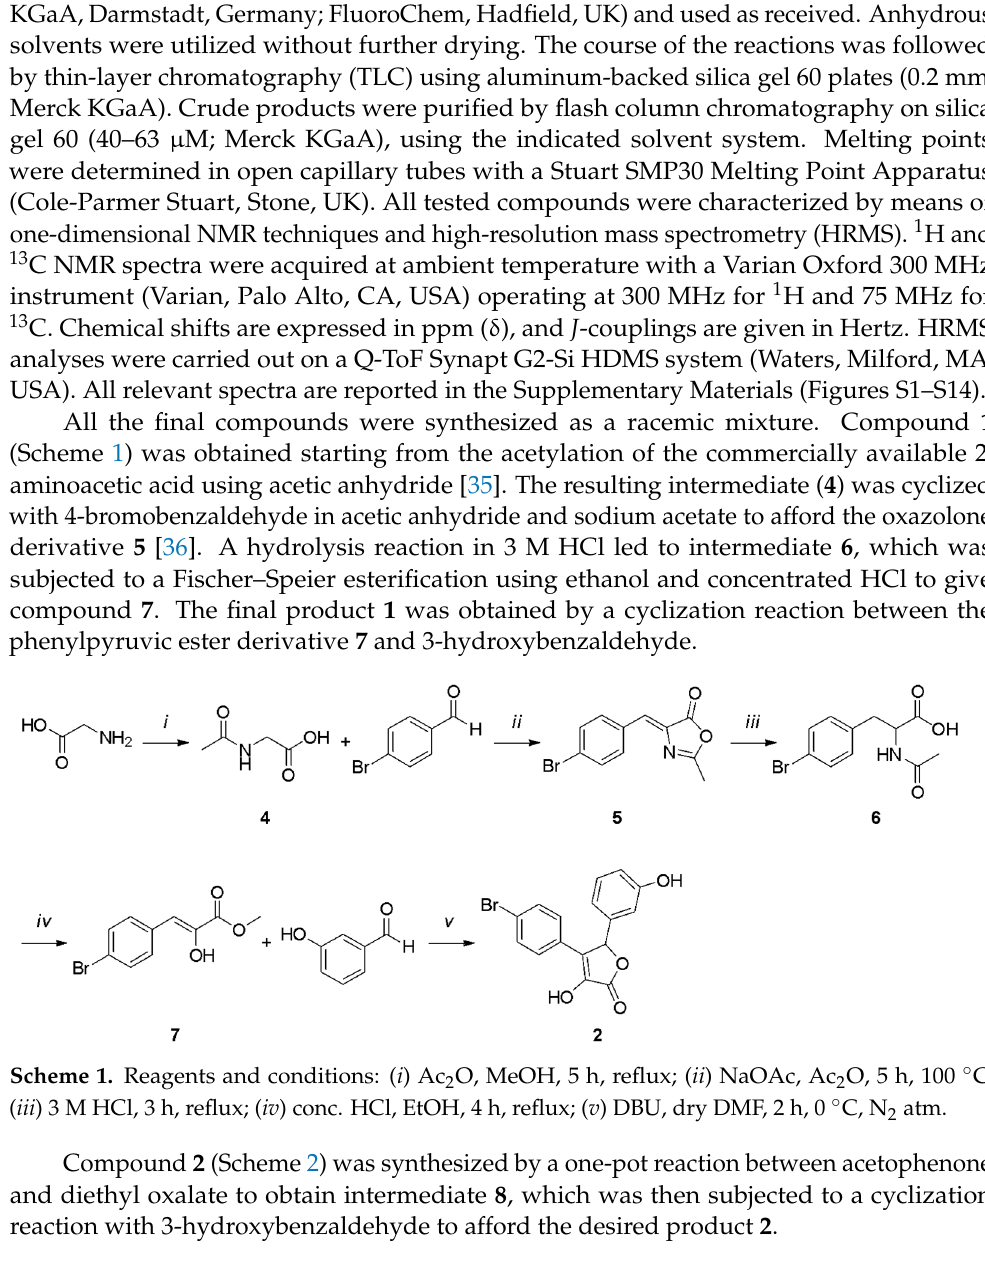
Figure 2. Chemical structures of BLI, 4 ‐ (4 ‐ bromophenyl) ‐ 3 ‐ hydroxy ‐ 5 ‐ (3 ‐ hydroxyphenyl)furan